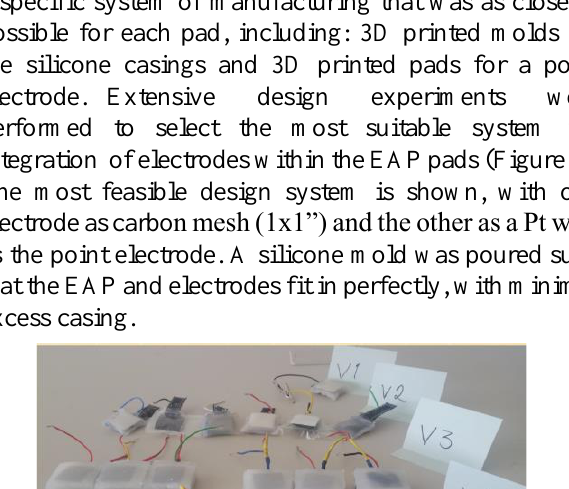
Figure 3. Simple Sensing Demo using Analog Multimeter.